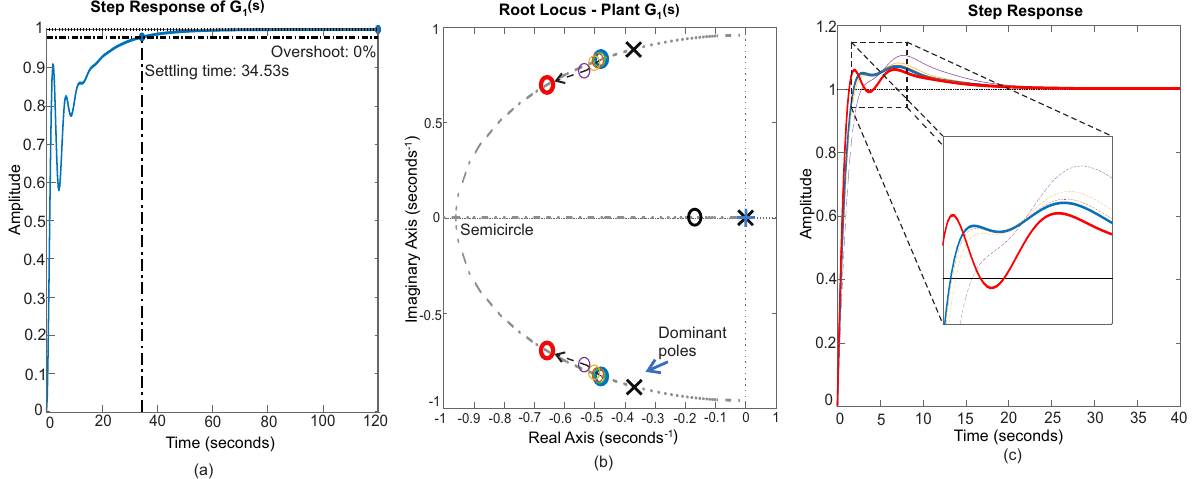
Figure 6. Plant G 1 (s) response and tuning using the proposed tuning system. ( a ) Overshoot and settling time without controller, ( b ) results of movement of zeros of PID controller using the proposed method, and ( c ) step response per iteration: final controller tuning and initial controller